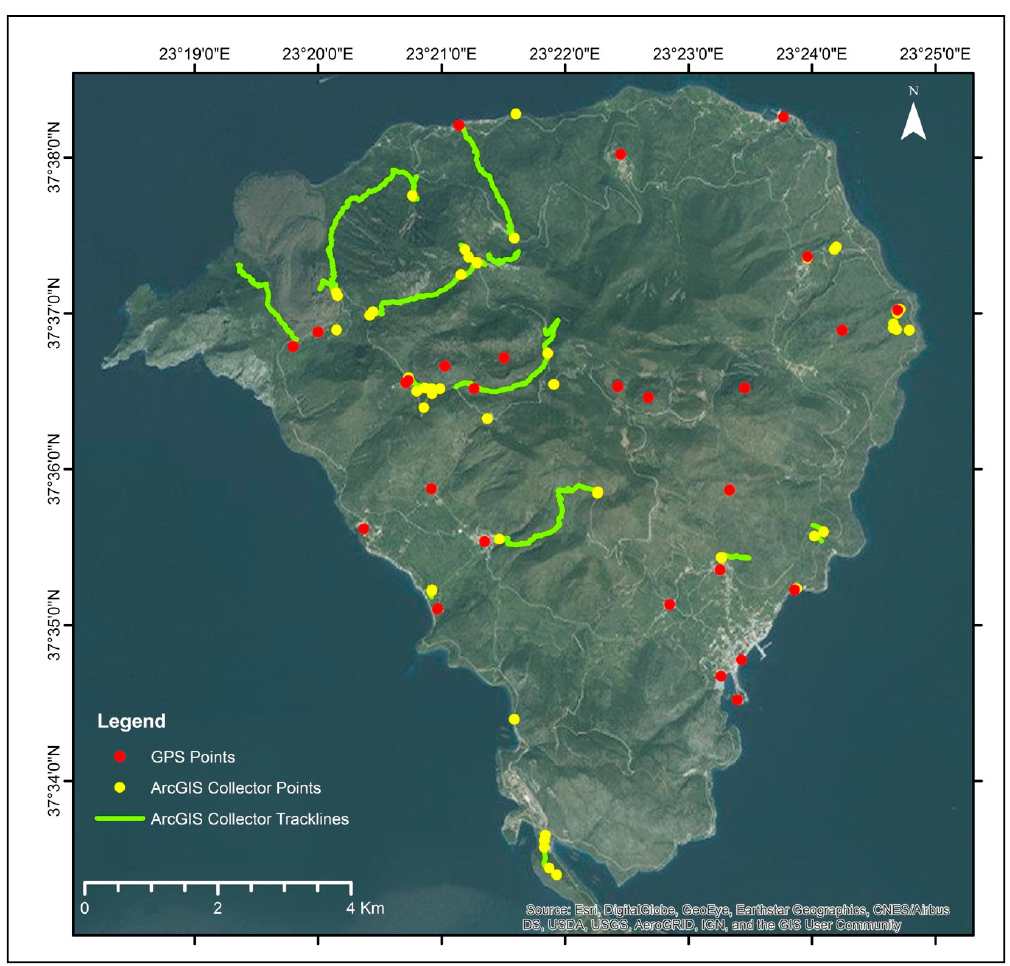
Figure 2. Screenshot which shows data that have been collected during field trips (adapted from [22])